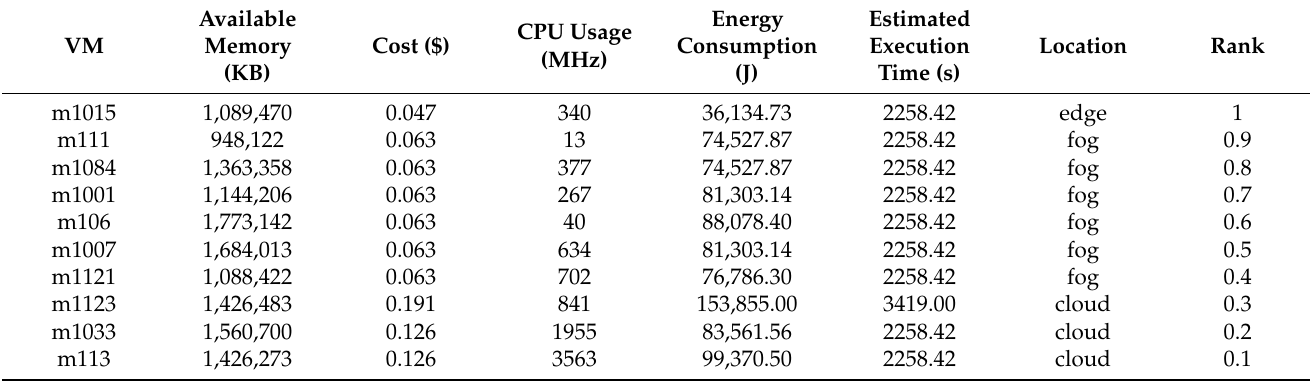
Table 21. Optimization results Task 334016 with energy consumption and CPU utilization use